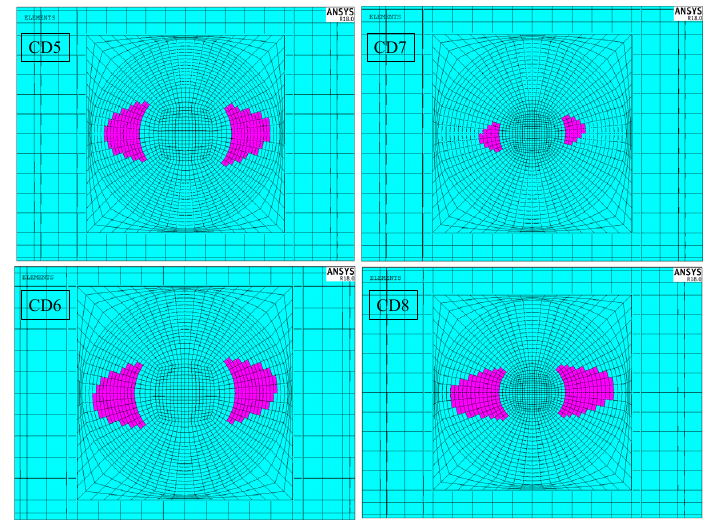
Figure 8. CD5–CD8 configurations: ( a ) delaminated area vs. load curves; ( b ) delamination evolution at final analyses load (pink represent the delaminated area).